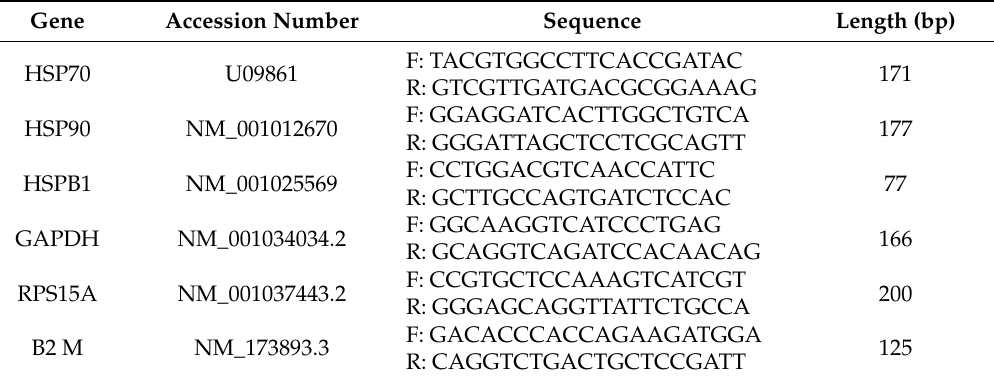
Table 2. Primer sequences, lengths and accession